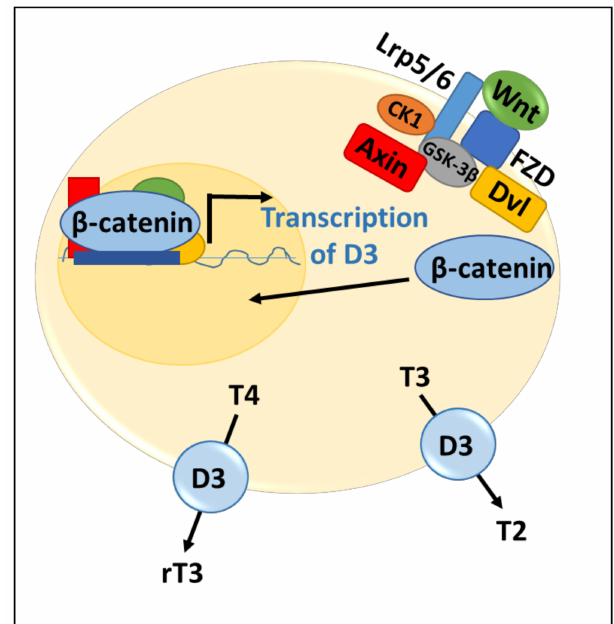
Figure 3. Wnt signaling pathway regulates deiodinases. Wnt ligand binds to the receptor, Frizzled (FZD), and the co-receptor, lipoprotein receptor-related protein 5 or 6 (Lpr5/6). Disheveled (Dvl) is then recruited, leading to phosphorylation of Lrp5/6 by casein kinase 1 (CK1) and glycogen-synthase kinase 3 β (GSK-3 β ). Axin then binds, allowing for β -catenin to accumulate and translocate to the nucleus to activate transcription of D3. D3 levels then increase and lead to inactivation of T4 to reverse triiodothyronine (rT3) and T3 to